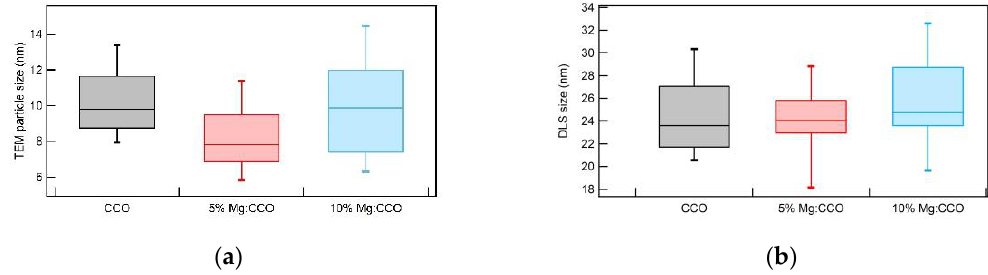
Figure 4. Box plots of ( a ) TEM-determined particle sizes from Figure 3 and ( b ) dynamic light scattering (DLS)-determined sizes for CCO (black color), 5% Mg:CCO (red color), and 10% Mg:CCO (blue color) nanoparticles. The percentiles are set to 90% whisker top, 75% box top, 25% box bottom, and 10% whisker bottom for each data set. In ( a ), ~50 individual nanoparticles are used in each data set. In ( b ), ~12 batches of DLS measurements are used in each data set.